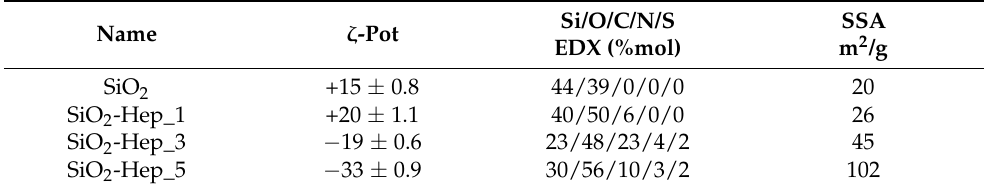
Table 5. Zeta-Potential ( ζ -Pot), SSA and EDX